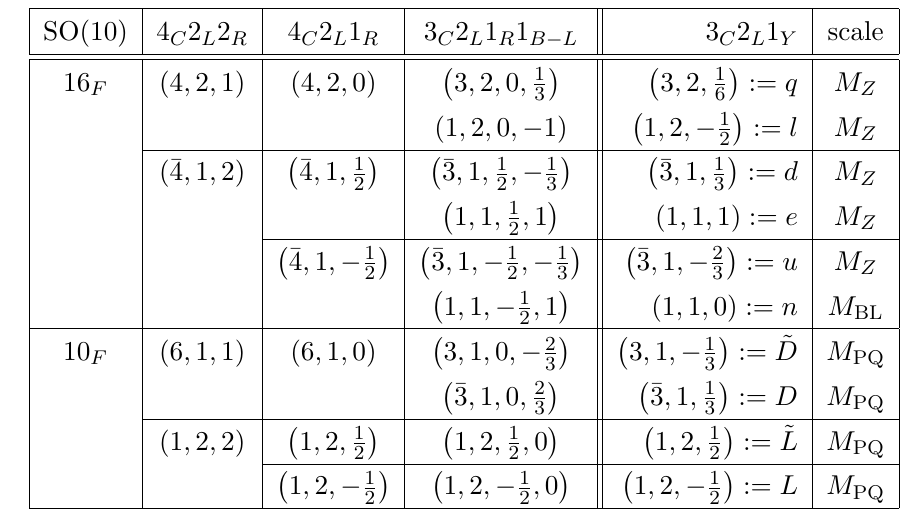
Table 4 . Decomposition of the fermion multiplets according to the various subgroups in our breaking chains. All SM fermions have masses set by the Higgs mechanism, the heavy right handed neutrinos acquire their mass at the BL breaking scale from the coupling to the 126 H . Fermions in the 10 F representation can obtain a mass from a Yukawa coupling to the 45 H or to a scalar singlet (if